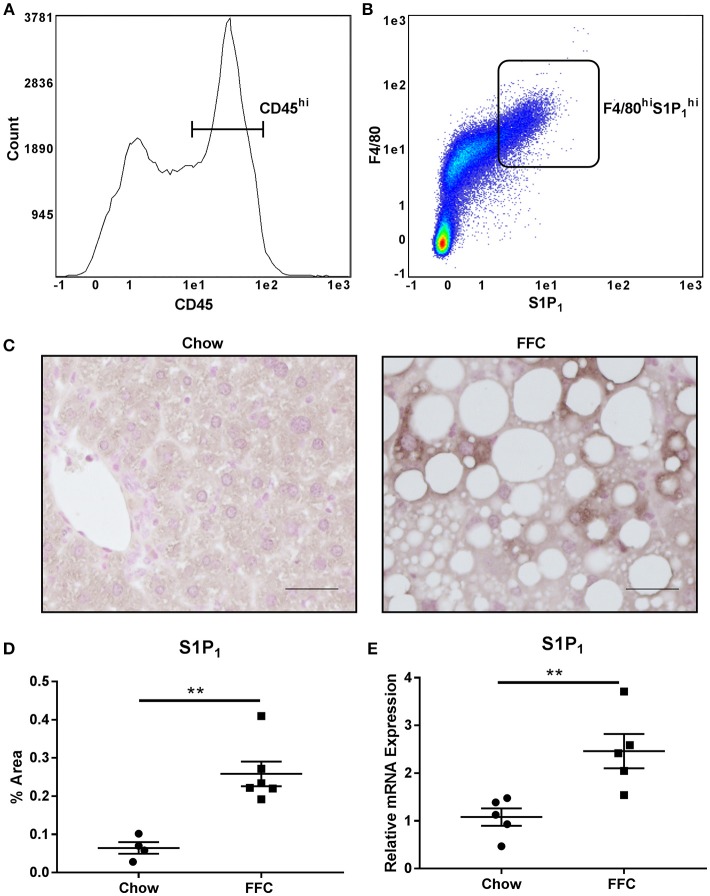
Intrahepatic macrophages express the S1P1 receptor. (A) CD45 expression and (B) F4/80 and S1P1 receptor expression of CD45hi intrahepatic macrophages was determined in normal mouse livers by FACS analysis. (C) S1P1 receptor immunohistochemistry was performed in livers from mice fed a diet high in fat, fructose and cholesterol (FFC) or chow for 20 weeks. Scale bar = 50 μM, n = 4 for chow and n = 6 for FFC. (D) Quantification of immunohistochemistry for S1P1 receptor in chow fed (n = 4) and FFC fed (n = 6) mice. (E) mRNA expression for S1P1 receptor in chow fed (n = 5) and FFC fed (n = 5) mice. **p < 0.01.